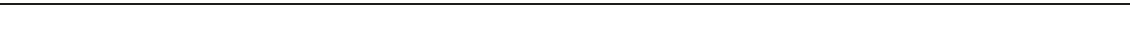
Fig. 4 High fi brillar collagen content resulting from Hh pathway activation promotes mechano-signaling and breast cancer stemness. a – d Concomitant expression analysis of collagen content and organization, integrin/focal adhesion activation and CSC-like characteristics at the tumor − stromal interface of M6 tumor models ± SMOi (100 mg/kg/bid; n = 3 biological replicates). a Representative multiphoton SHG imaging (scale bars: 100 μ m) and quantitative analysis of collagen abundance. Statistical signi fi cance was determined using unpaired two-tailed Student ’ s t test with equal s.d. Corresponding graphs comparing fi ber orientation (top right panel) and quantifying GLCM (bottom right panel). Unpaired two-tailed nonparametric Mann – Whitney U test was used for determining statistical signi fi cance across distributions. For GLCM analysis, statistical signi fi cance was determined using unpaired two-tailed Student ’ s t test with equal s.d. b Collagen I and III deposition detected and quanti fi ed by picrosirius red staining. Scale bars, 200 μ m. Statistical signi fi